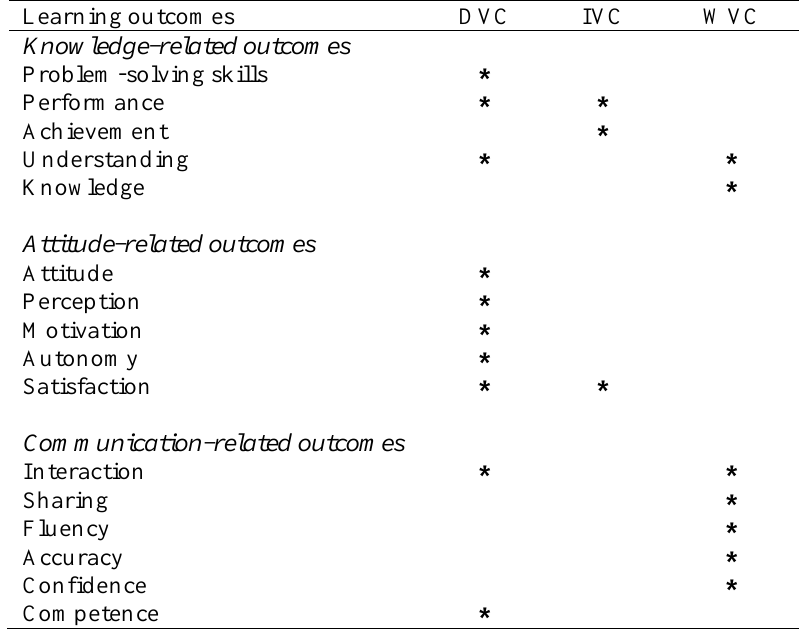
Learning Outcomes Reported in the Studies Associated With the Use of DVC, IVC, and WVC Learning outcomes DVC IVC WVC Knowledge-related outcomes Problem-solving